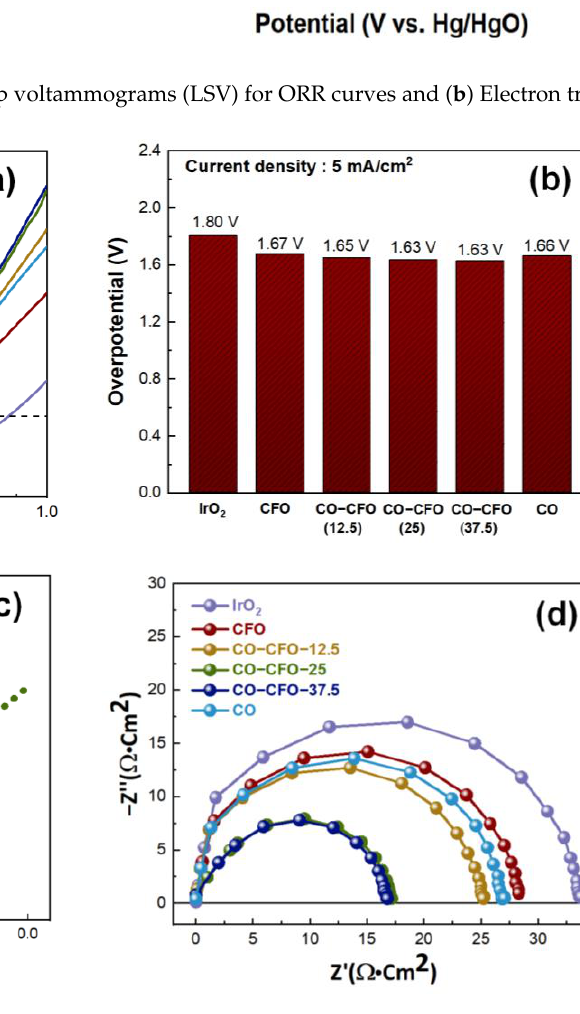
Figure 7. ( a ) Linear sweep voltammograms (LSV) for OER curves, ( b ) OER overpotential values of the electrodes measured at the same current density of 5 mA/cm 2 , ( c ) Tafel slope in OER of electrodes, ( d ) electrochemical impedance spectroscopy (EIS) of electrodes measured in the range of 7 MHz to 10 mHz.